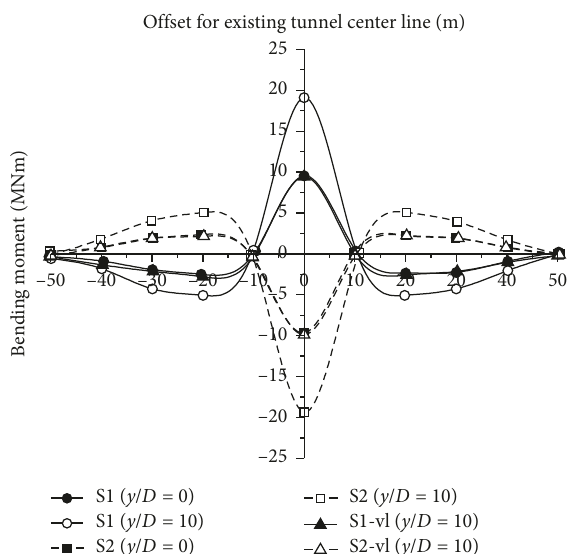
Figure 12: Longitudinal bending moment of the existing